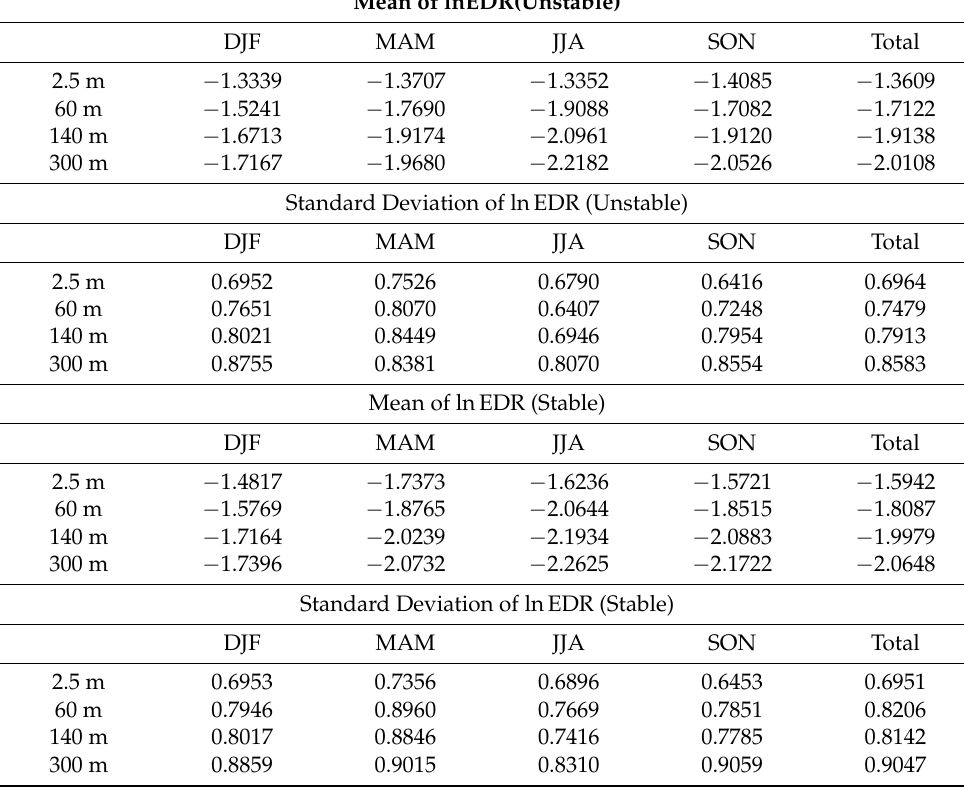
Table 2. The mean and the standard deviations of lnEDR1 in the (top) unstable and (bottom) stable PBL, for each season (DJF, MAM, JJA, and SON), and for the 1-yr period (Total) in 2018. Mean of lnEDR(Unstable) DJF MAM JJA SON